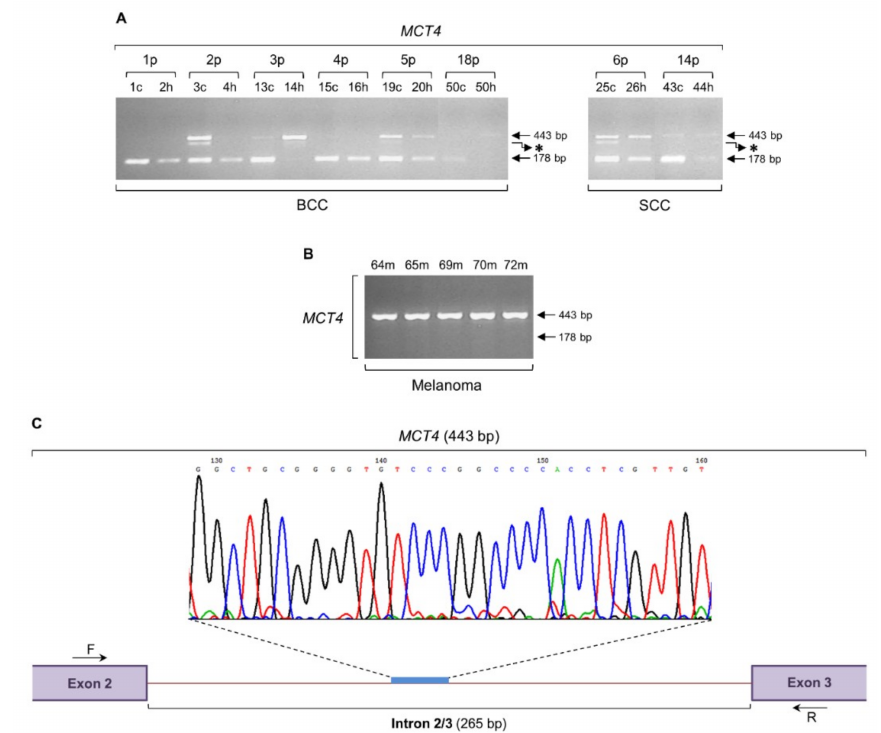
Figure 2. MCT4 intron retention is activated both in non-melanoma (BCC and SCC) and melanoma biopsy collections. Patterns of MCT4 transcriptional activity, through engagement of RT-sqPCR platforms based on total RNA extraction from BCC and SCC ( A ), or melanoma ( B ) biopsy samples. GAPDH was used as control gene (also, see Figure 6F and Table S1). ( C ) Representative DNA sequence chromatogram of the melanoma-specific 443 bp long PCR fragment. A characteristic MCT4 intron 2/3 (265 bp) sequenced area is indicated. Besides the retention of MCT4 intron 2/3 (443 bp), note the absence of gene’s normal transcriptional activity (lack of 178 bp) in all melanoma cDNA samples ( B ). p: patient, c: cancer tissue (biopsy), h: healthy tissue (biopsy), m: melanoma (biopsy), bp: base pair, F: forward (primer), R: reverse (primer) and asterisk (*): aberrant splicing-derived PCR